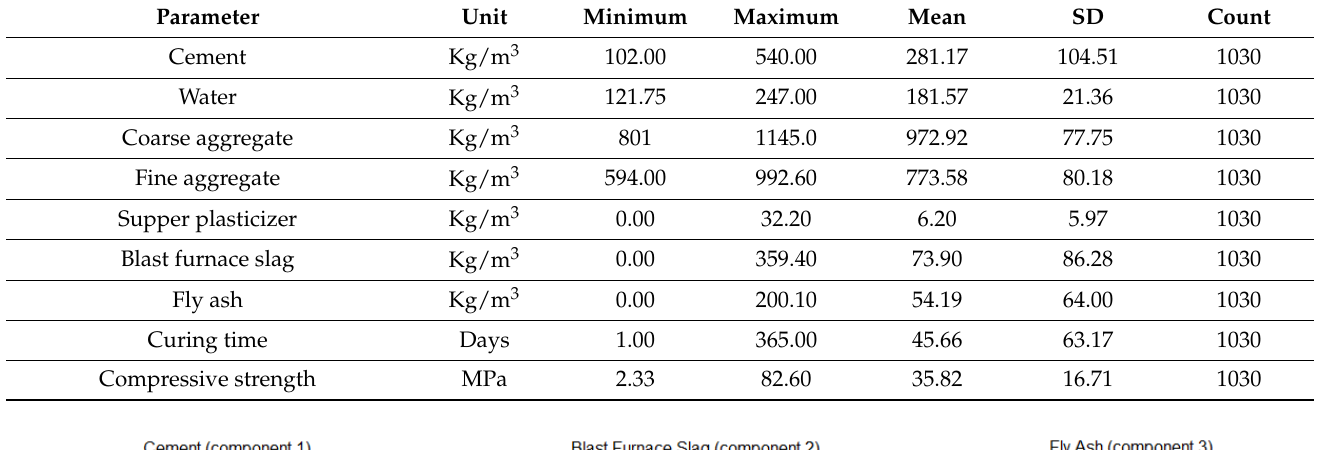
Table 1. Statistical input variables of the datasets. These information is used to train the proposed regression methods and predict the concrete compressive strength.